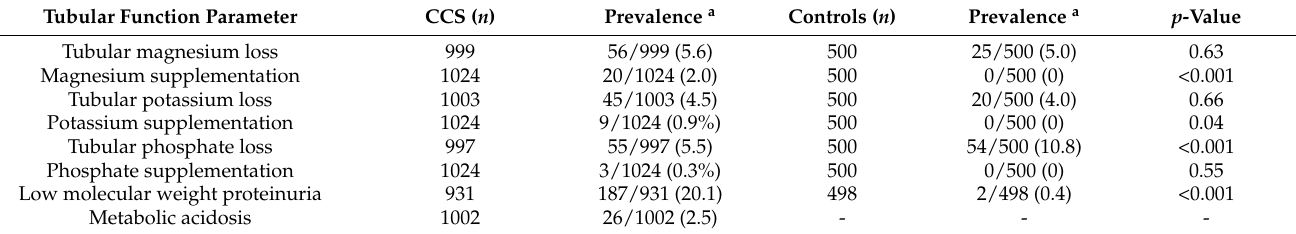
Table 3. Prevalence of tubular dysfunction in childhood cancer survivors compared to matched